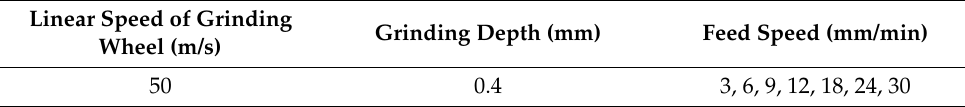
Table 2. Grinding process parameters.